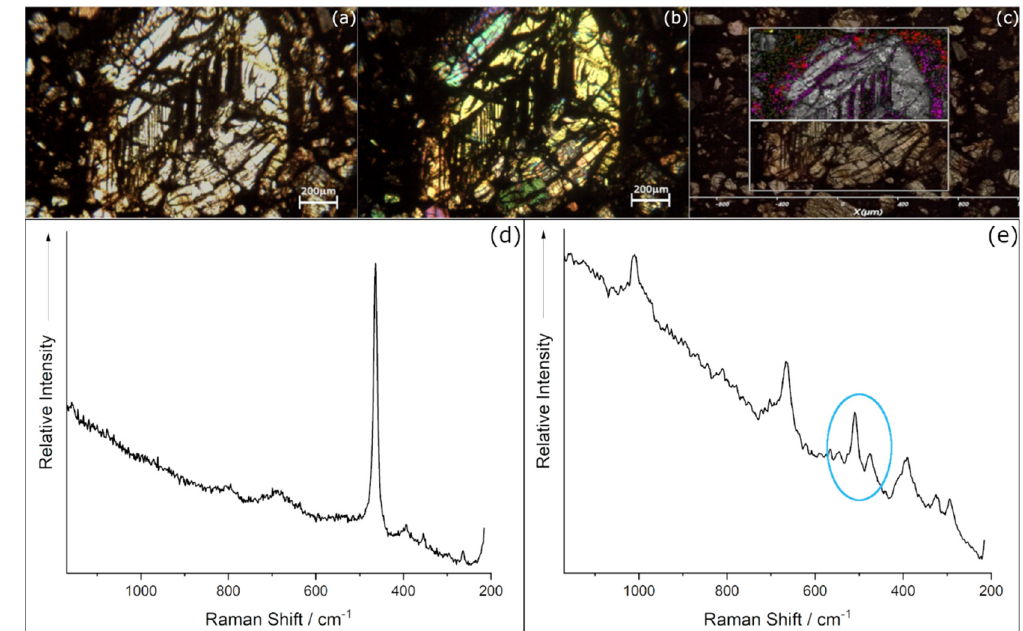
Figure 5. OM images and µ-RM of chondrule B: ( a ) OM image plane-polarized transmitted light; ( b ) OM image cross- polarised transmitted light; ( c ) µ-RM results overlapped on the OM image, the white thick square indicates the mapped area and the different colours correspond to the different mineral phases, identified on the basis of the Raman Bands spectra: Forsterite (grey), Enstatite (red), Diopside (purple), Hematite (green), Anhydrite (blue), ( d ) Quartz (yellow) and Raman spectrum without any bands, corresponding to the black areas; ( e ) µ-RM spectrum observed in some areas at the rime of the diopside crystal, the circled bands at 476 and 510 cm − 1 are consistent with feldspar phase, while the others are ascribable to diopside.